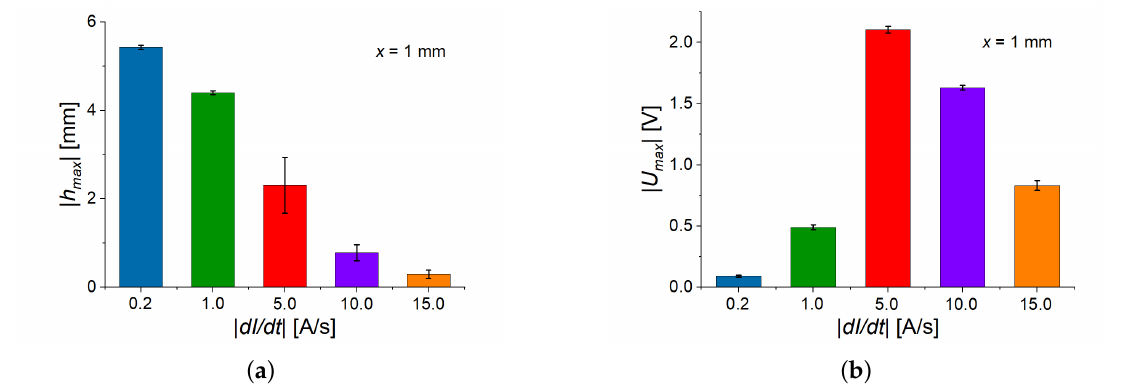
Figure 6. Peak deflection ( a ) and peak induced voltage ( b ) for different slew